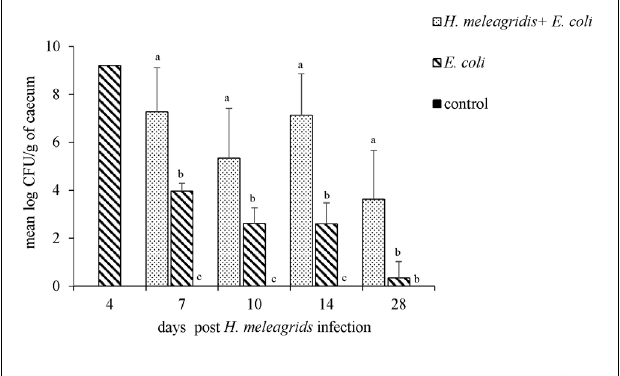
FIGURE 11 | Quantification of the lux -tagged E. coli in the cecum of infected birds. One bird died from group 2 at 4 dpi. At 7, 10, 14, and 28 dpi sampling were performed in four birds from each group with an exception at 7 dpi when only three birds from group 2 were killed. Results are represented as means ± SEM. Numbers of bacteria are expressed as (log CFU/g). Bars with different letters within each sampling point denote significantly different